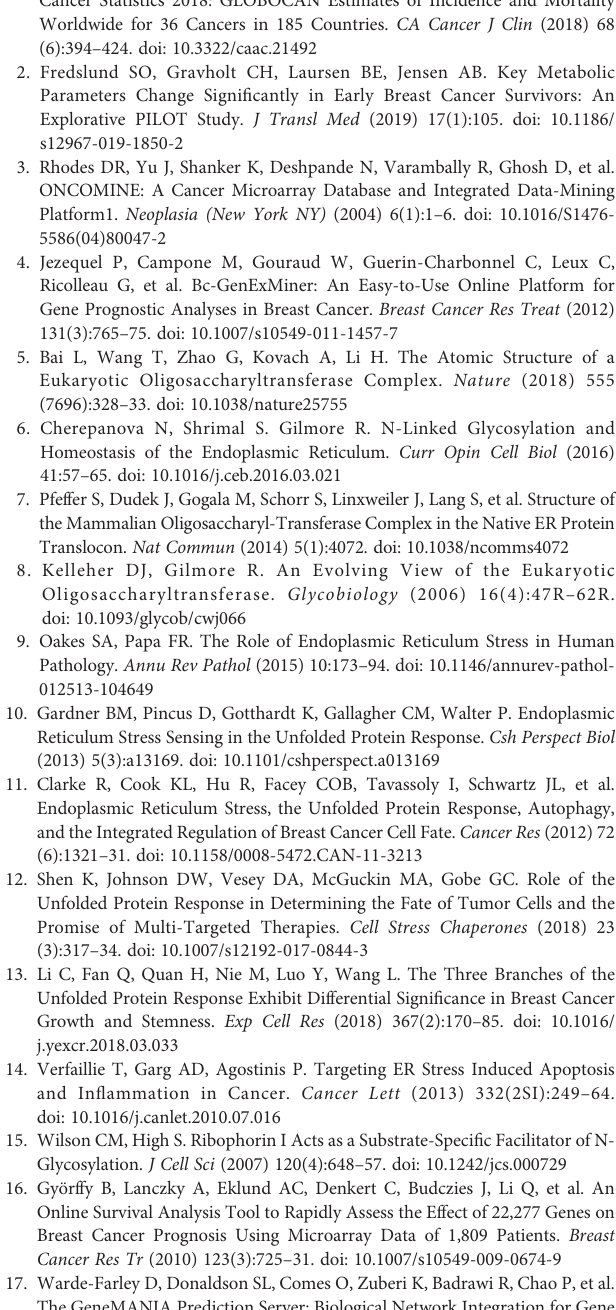
computed for each pairwise comparison. P<0.05 was considered statistically signi fi cant. NPI, Nottingham Prognostic Index. Supplementary Figure S6 | Survival analyses of the OST subunits in breast cancer (RFS in Kaplan – Meier Plotter). (A – L) RFS for individual OST subunits in all breast cancers. P<0.05 was considered statistically signi fi cant. RFS, relapse-free survival; HR, hazard